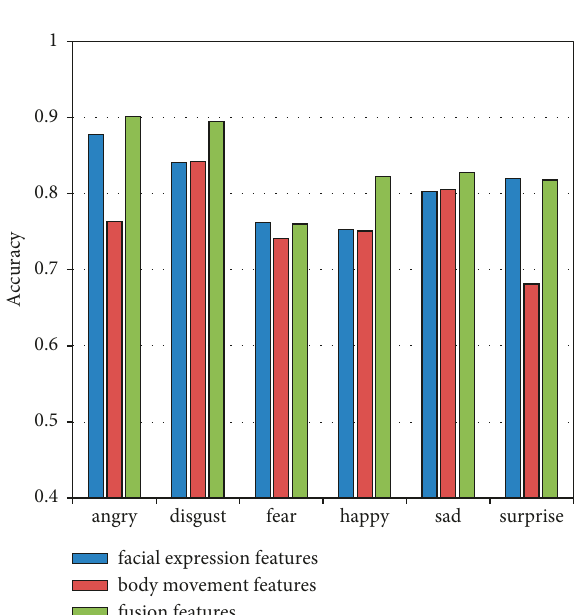
Figure 5: Comparison of emotion recognition results based on fusion